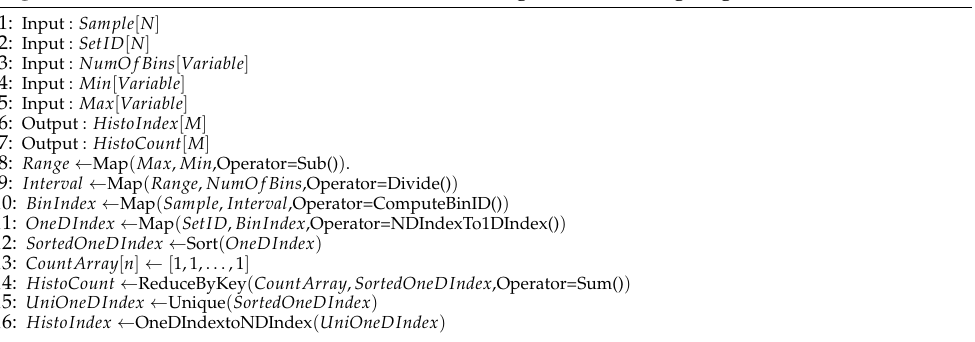
Algorithm 2 DPP Version of the Multi-set Histogram Modeling